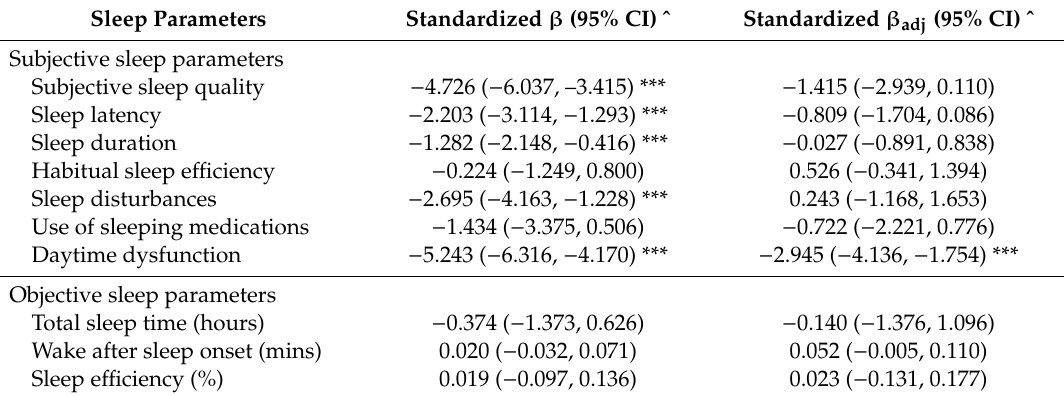
Table 4. Association between objective and subjective sleep parameters on mental health-related quality of